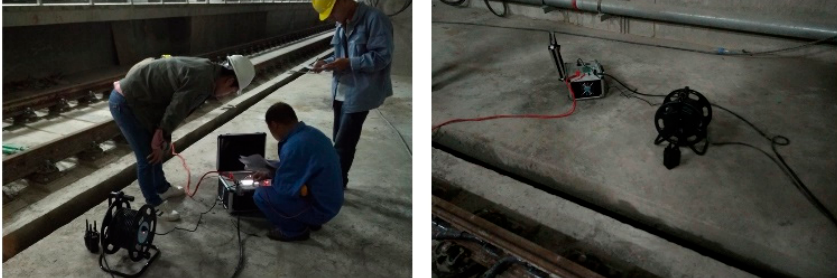
Figure 13. Field test on the transition resistance and rail longitudinal resistance. ( Left ) Parameters test; ( Right ) Test box.